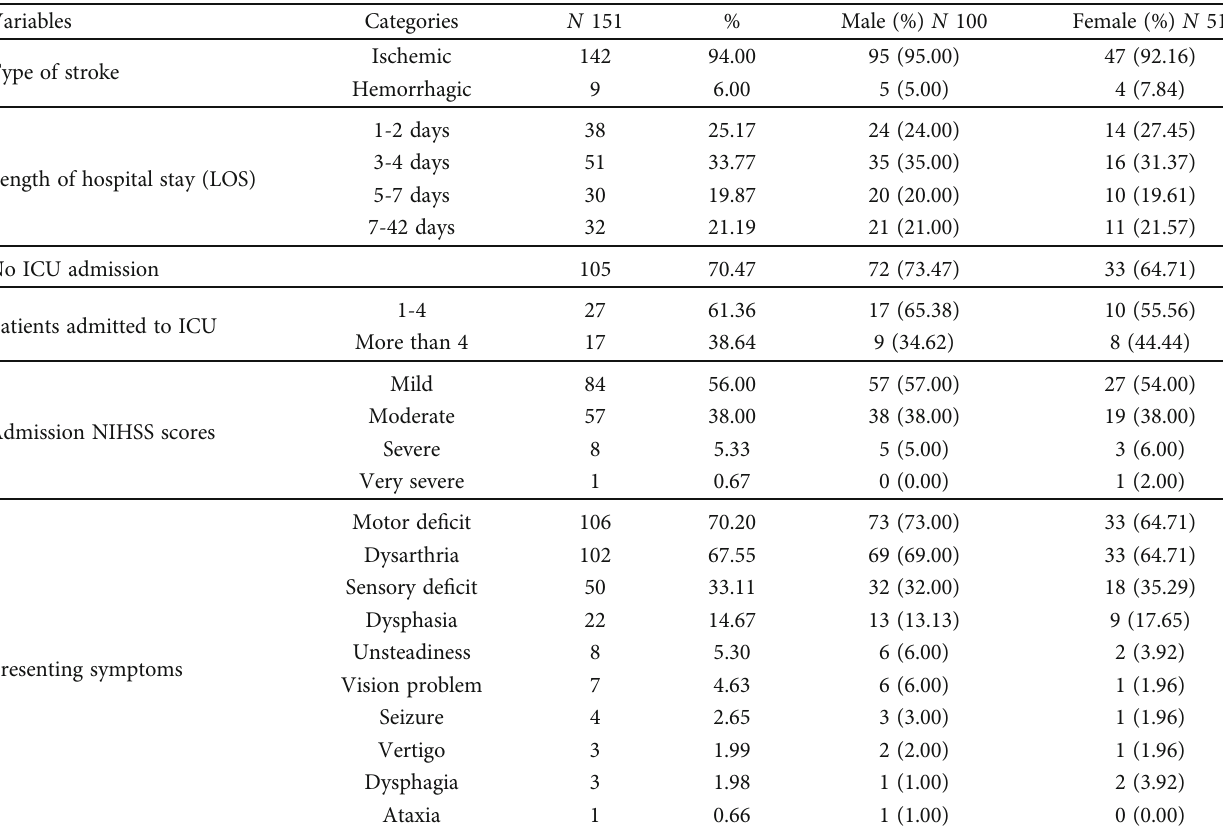
Table 2: Stroke type and severity.